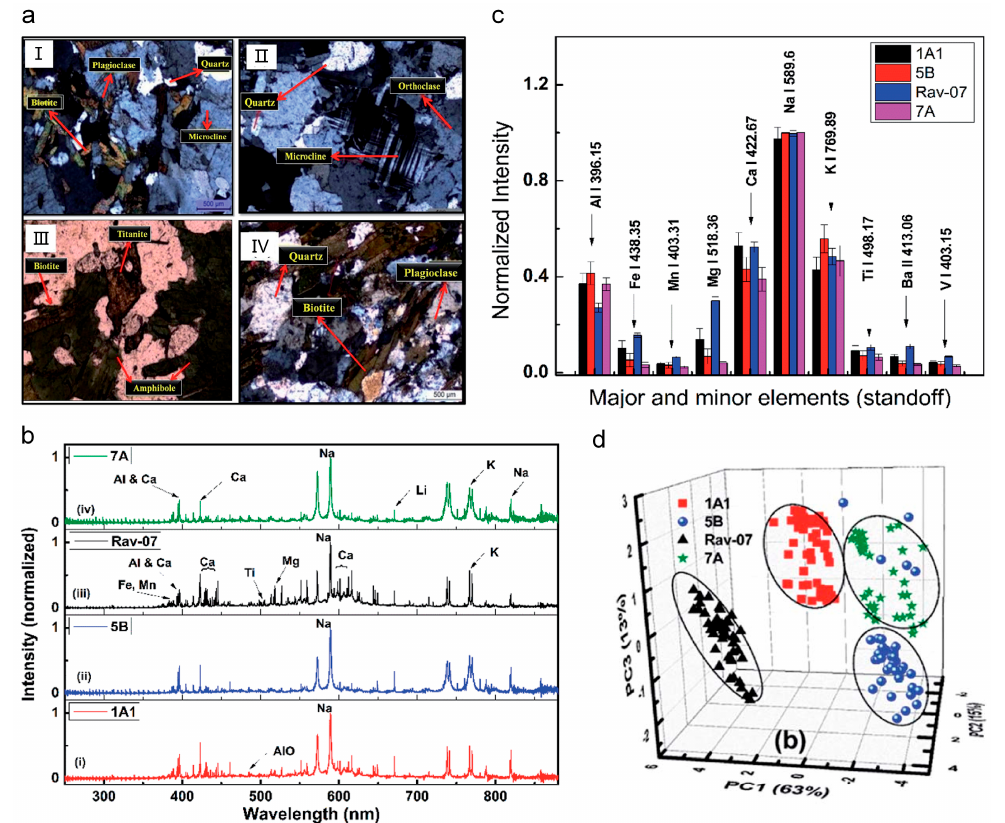
Figure 20. ( a ) Photomicrographs of (I) Tonalite-1A1, (II) Granite-5B, (III) Maficenclave-Rav-07, and (IV) Granodiorite-7A depicting the textures and modal mineral assemblages of different granitoids. ( b ) Typical normalized standoff FIPS spectra of granitoids in ( a ). ( c ) Atomic peak intensities of major elements for the granitoids in ( a ). ( d ) PCA score plots of the normalized FIPS spectra of granitoids in ( a ) [309].